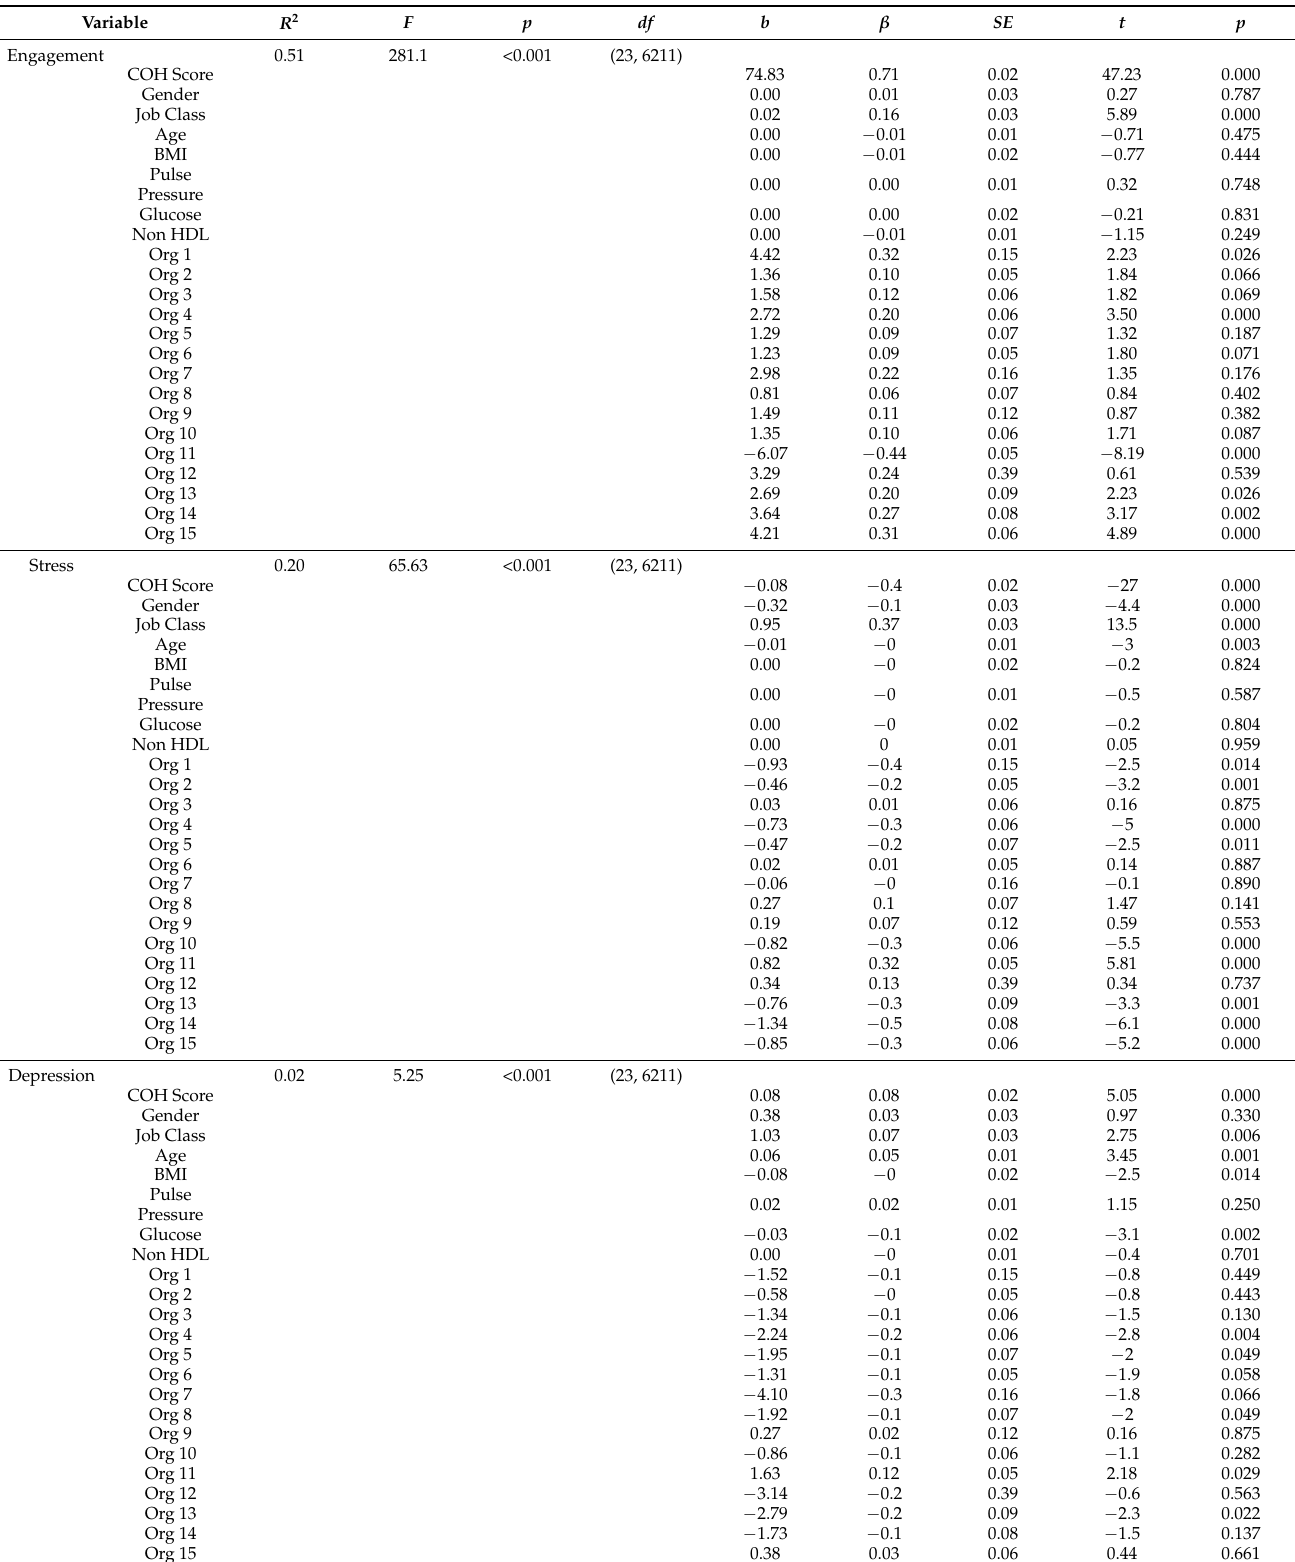
Table A2. Results of Regression with all